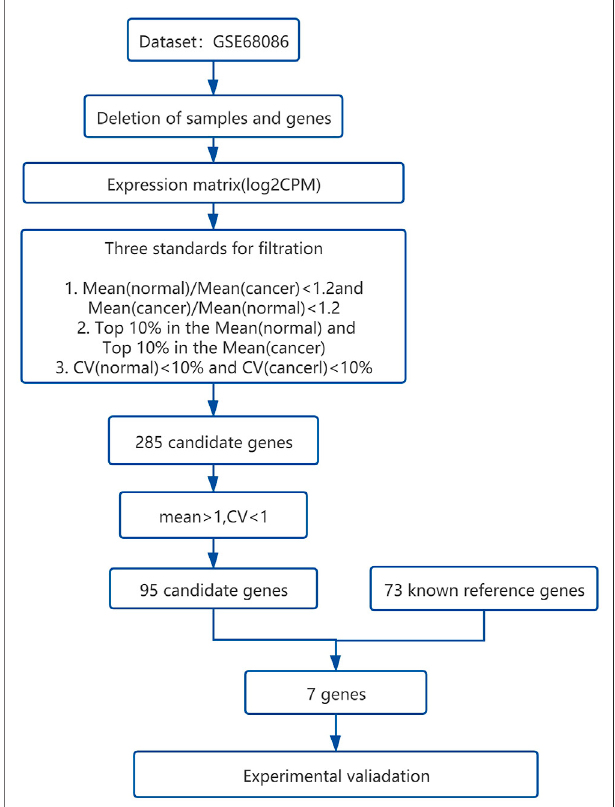
FIGURE 1 | The overall work fl ow of bioinformatical statistics for screening the candidate reference genes from the platelet RNA sequencing data